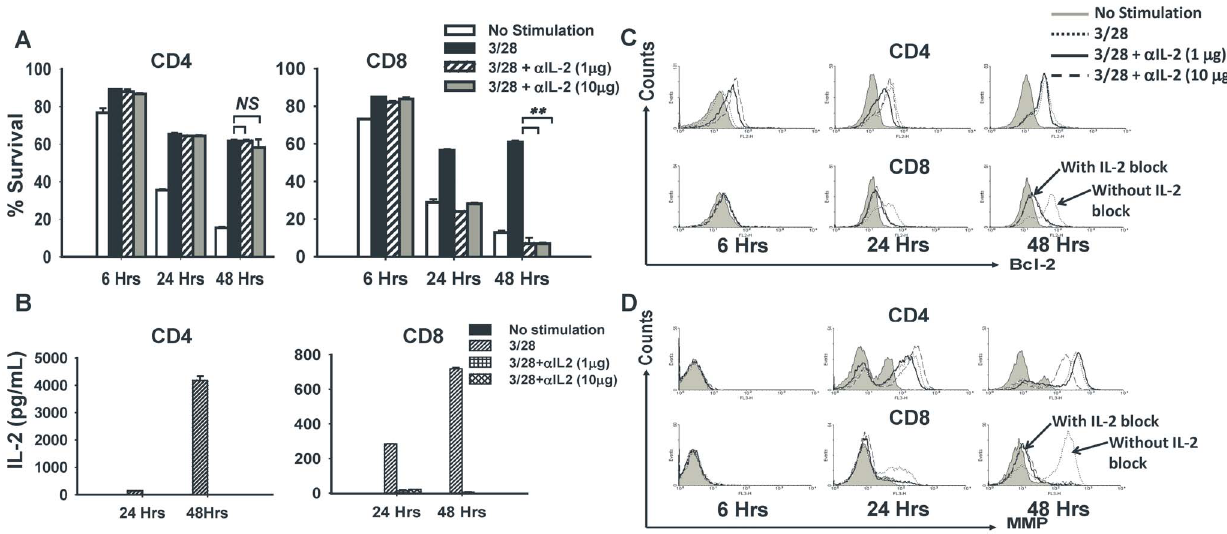
Figure 1. Neutralizing IL-2 reduces the survival of CD8 + but not CD4 + T cells. CD4 + CD25 2 and CD8 + CD25 2 T cells were purified from wild- type B6 mice and stimulated with anti-CD3/CD28 mAbs in the presence or absence of neutralizing IL-2 mAb at two different concentrations as indicated. Some cells were left unstimulated (no anti-CD3/CD28) and were used as negative controls. A total of 5 6 10 4 cells per well were cultured in flat-bottom 96-well plates and harvested for analysis at the indicated time points. ( A ) Harvested cells were stained with Propidium Iodide (PI) to measure cell survival by flow cytometry. Bar graphs show the percentage of PI negative cells in each group (n=3). ( B ) Supernatants were harvested from the cultures at the indicated time points which were then analyzed for levels of IL-2 using ELISA. Bar graphs show the concentration of IL-2 in the culture supernatants. ( C ) Histograms show the expression of the anti-apoptotic protein Bcl-2 measured by flow cytometry in the cultured cells at the indicated time points. ( D ) Histograms represent the mitochondrial membrane potential measured by flow cytometry of harvested cells (with higher fluorescence depicting a hyper-polarized state of mitochondria) at the indicated time points. The figure shows results from one representative experiment which was repeated three times with similar results. Bars indicate average value 6 standard deviation (SD) obtained from three culture wells (technical triplicates) in each experimental group (*denotes p , 0.05 and **denotes p , 0.005).